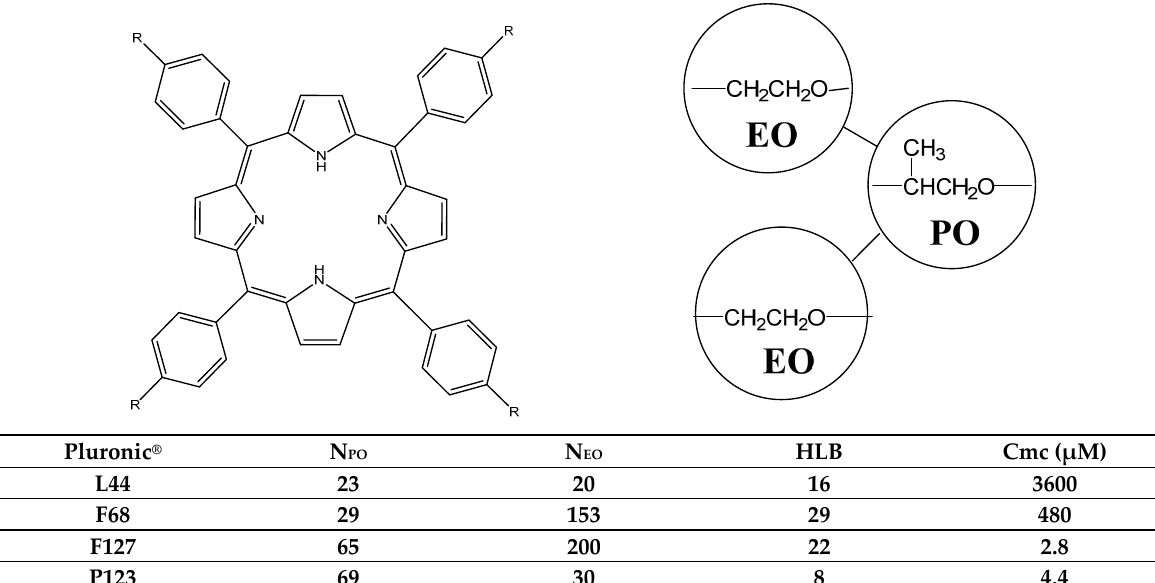
Figure 9. Left side: structural formula of porphyrin PSs possessing different ligands in the p -position of the phenyl group: trimethylaminium (TAPP, R = N + (CH 3 ) 3 ); hydroxyl (THPP, R = OH); sulfonic (TSPP, R = SO 3 H); carboxylic (TCPP, R = COOH). Right side: the Pluronic block copolymers L44, F68, F127 and P123. Bottom: average number of ethylene oxide groups (N EO ), average number of propylene oxide groups (N PO ), hydrophilic–lipophilic balance (HLB) values and critical micelle concentration (Cmc) values